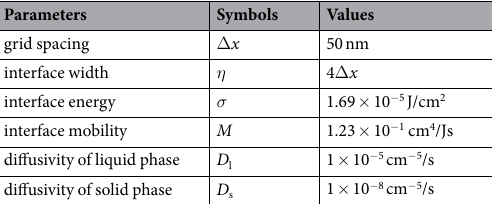
Here , a , b , c are the adjustable parameters, the nucleation rate ( f n ( ) ) and the time ( τ ) are normalized values of nucleus will precipitate faster in the place where the driving force is larger. Then the nucleation rate shows a